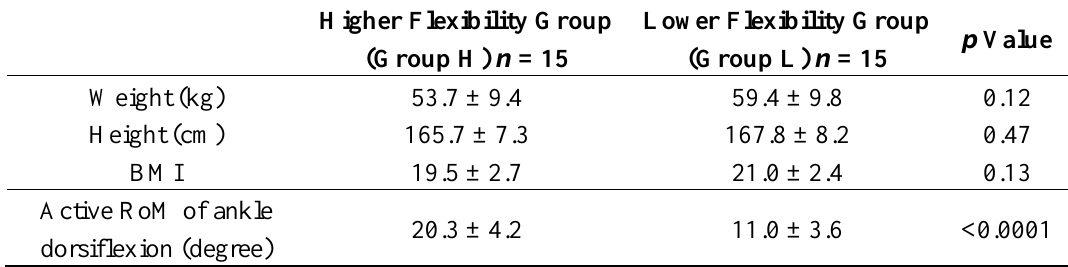
Table 1. Characteristics of the subjects grouped by Active RoM of ankle dorsiflexion, expressed in mean